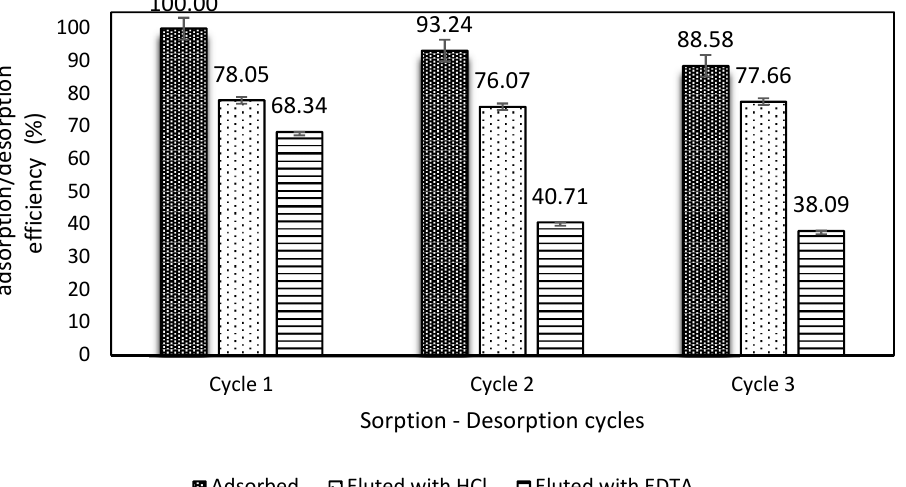
Figure 7. Adsorption–desorption cycles (Co = 50 mg/L, dose: 1 g/L, reaction time: 24 h, agitation: 150 rpm).